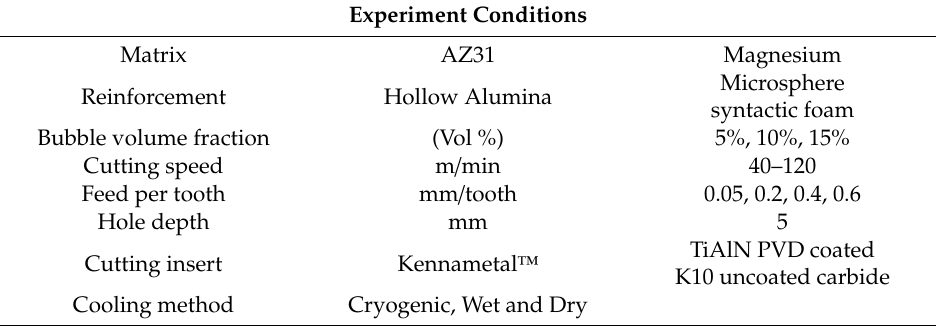
Table 3. Experiment